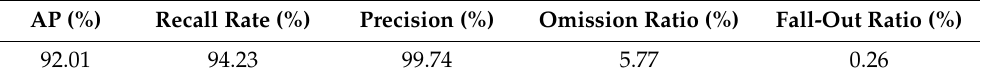
Table 2. YOLOv3 test results at 4000 iterations.